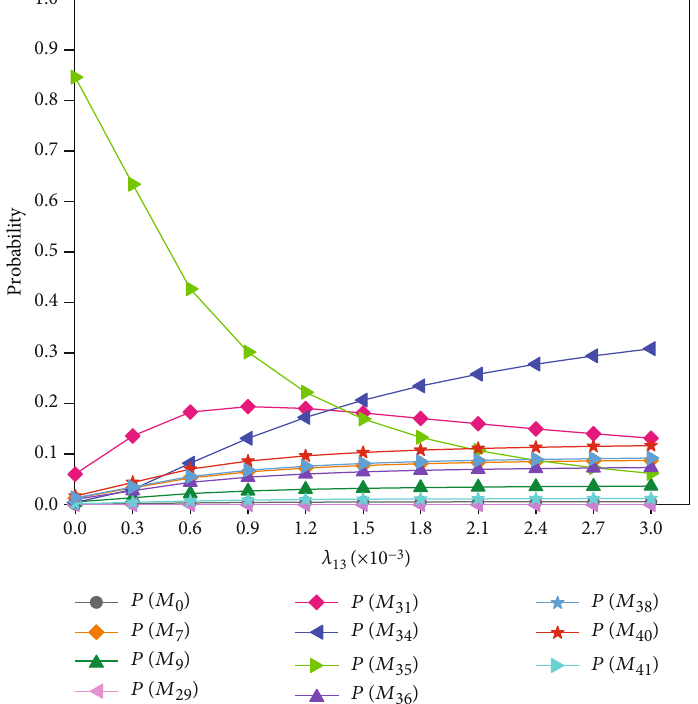
Figure 9: Variation of system probability with change in λ